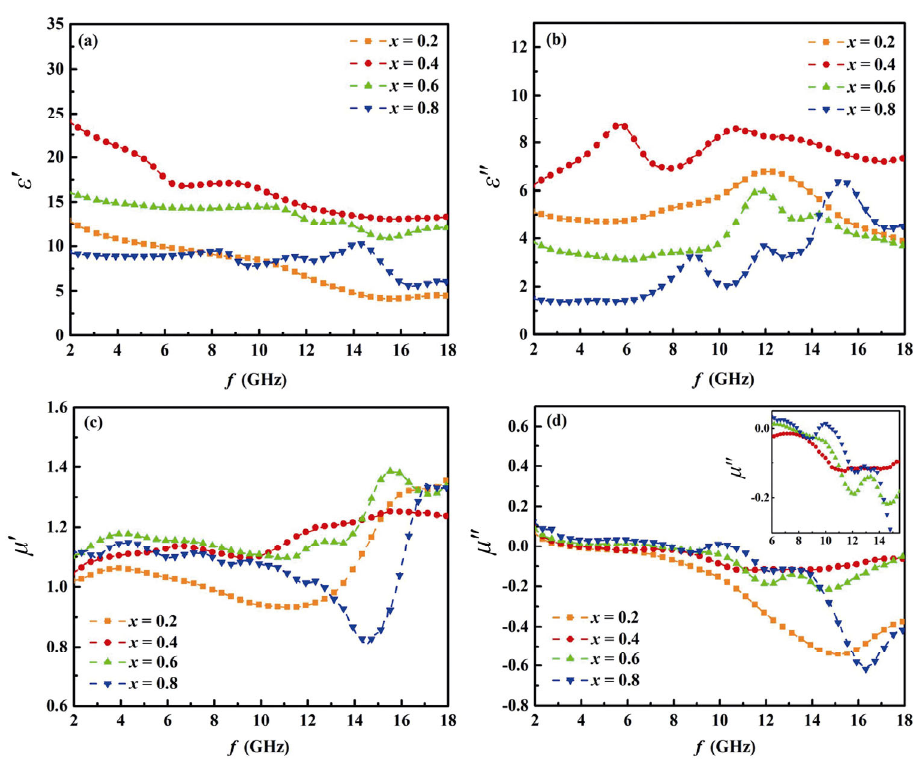
Fig. 4 Electromagnetic parameters of PVA mixed BFTO- x ceramics: (a) real parts and (b) imaginary parts of the complex permittivity, and (c) real parts and (d) imaginary parts of the complex